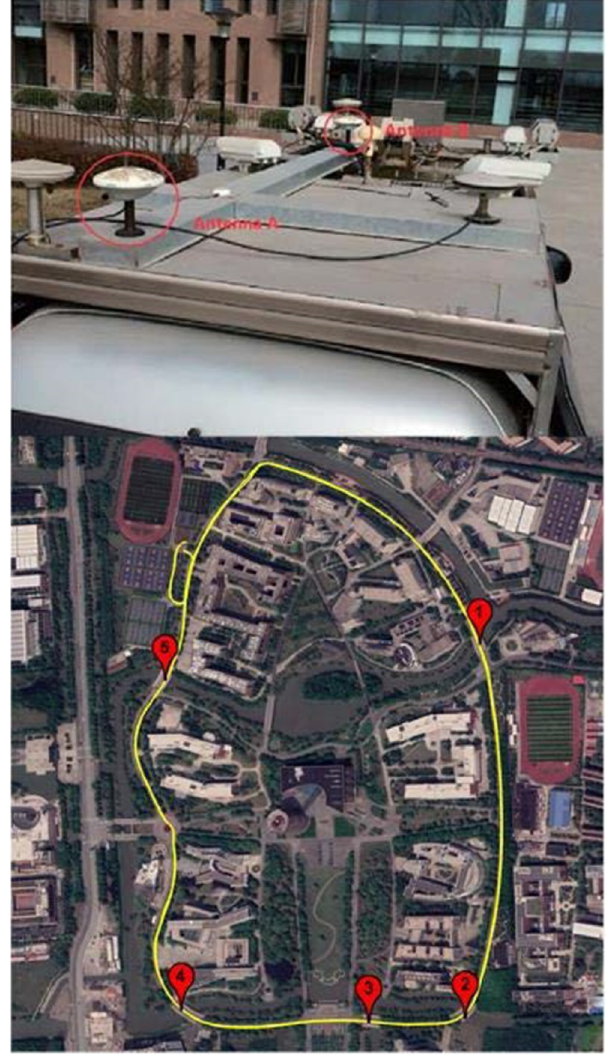
Figure 8. Photographs of the placement of two antennas ( top ) and dynamic experimental trajectory ( bottom ).